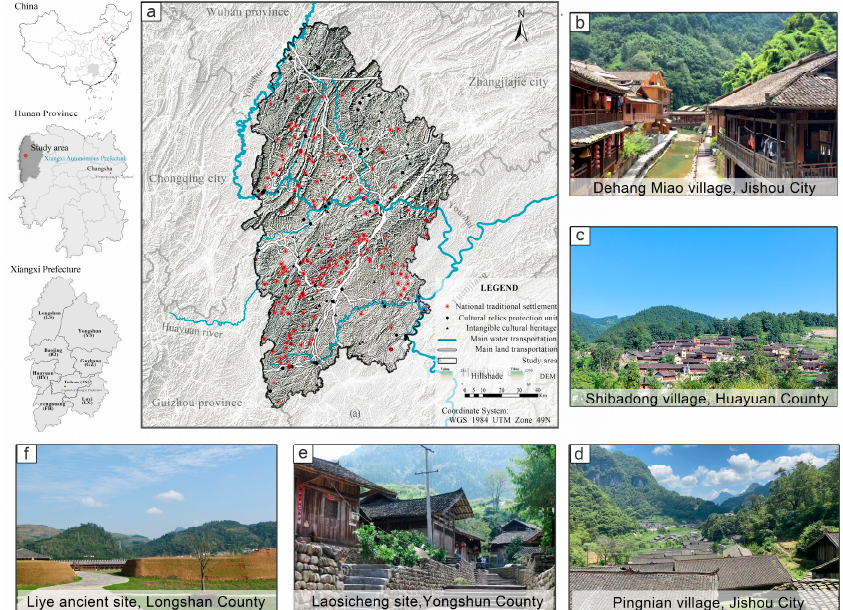
Figure 1. The geographical location of Xiangxi Prefecture and the spatial distribution of its cultural heritage resources ( a ), as well as photographs taken at cultural heritage sites involving Dehang Miao village, Jishou City ( b ), Shibatong village, Huayuan County ( c ), Pingnian village, Jishou City ( d ), Laosicheng site in Yongshun County ( e ) and Liye ancient site, Longshan County ( f ).